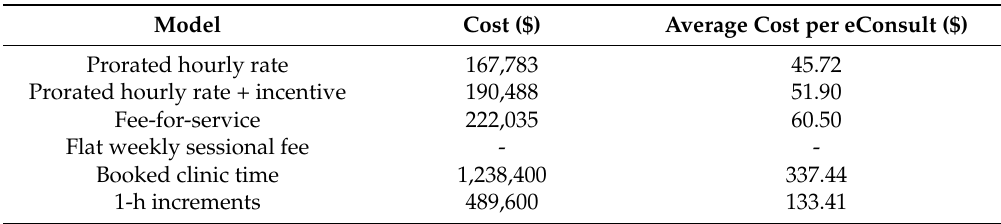
Table 2. Total cost and average cost per eConsult for different remuneration models.